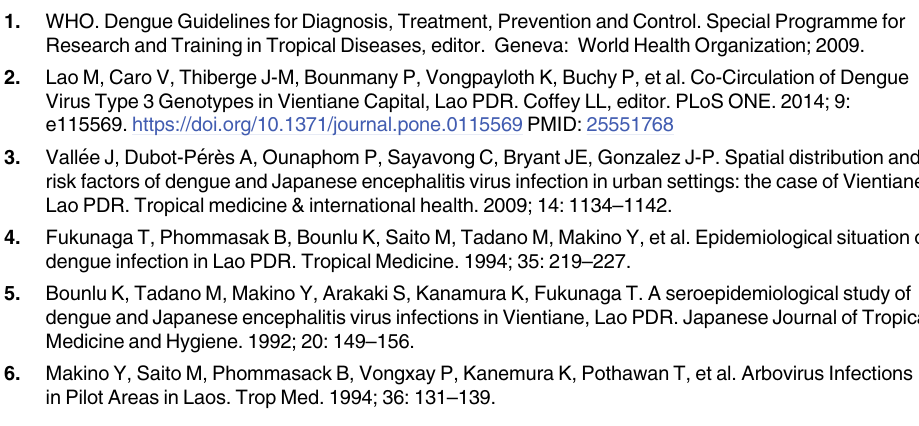
S3 Table. Kdr analysis, crude data from Genepop. S4 Table. V1016G and F1534C genotypic differentiation and haplotype differentiation between dead and live mosquitoes for DDT and